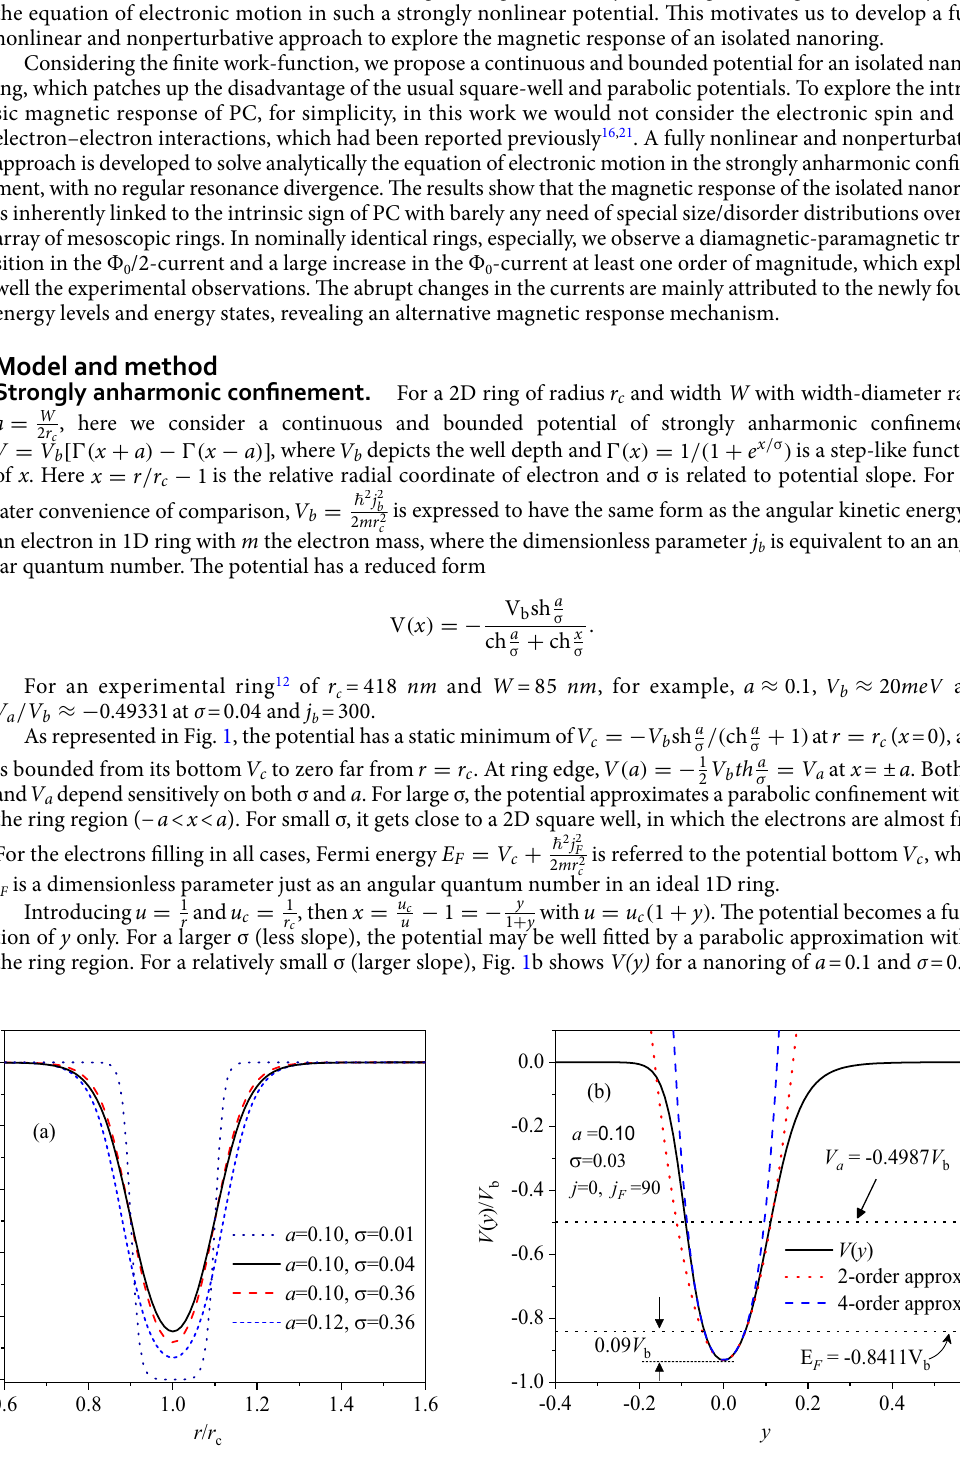
Figure 1. A continuous and bounded potential model for a nanoring of radius r c and width W under j = 0: (a) V(r) with various a and σ; (b) V ( y ) with a = 0.1 and σ = 0.03, as well as its 2- and 4-order polynomial 0.4987 V b and E F 0.09 V b 0.8411 V b at j V c approximants, where V a F = 90 and j b = 300, as shown by ≈ − = + ≈ − two horizontal dotted